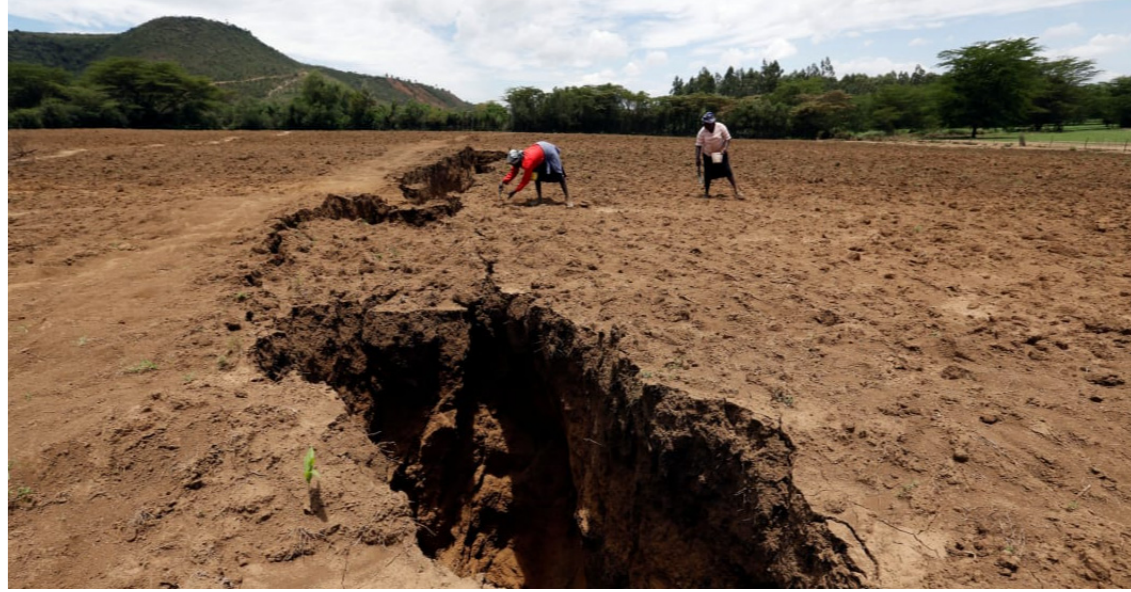
Figure 2. A rift in a Kenyan field leading to the formation of gullies. Source: CNN